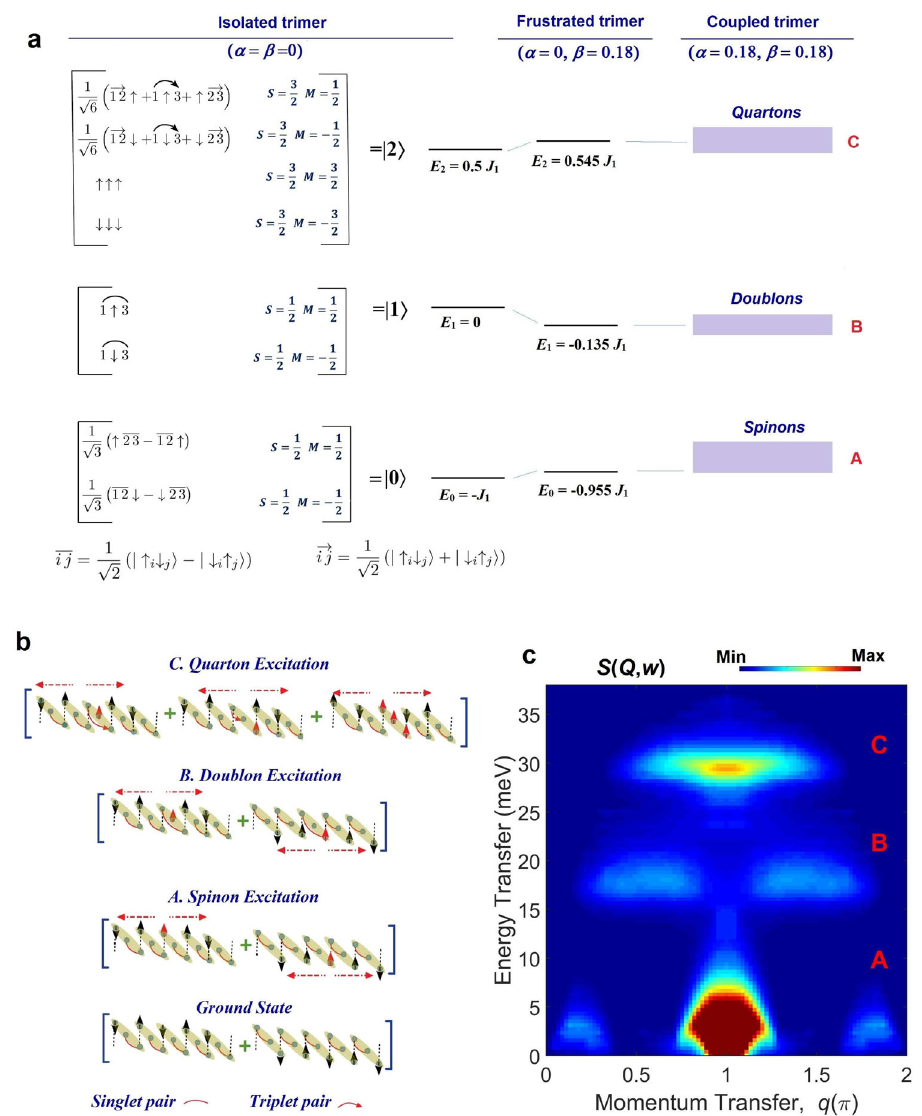
Fig. 2 | The energy level spectrum, wave functions, spin structures, and exci- tation spectrum of coupled spin-1/2 trimer-chain for the Hamiltonian of Na 2 Cu 3 Ge 4 O 12 .a Thelevelspectrumandcorrespondingwavefunctionsofisolated trimer in presence of (left) only NN J 1 and (middle) both NN and NNN interactions [ J 1 ,( J 3 = β J 1 with β =0.18)].The fi rstcolumnshowsthewavefunctionswhereisolated up and down spins are represented by up and down arrows, respectively and the singlet and triplet pairing between sites is denoted by lines and arrows, respec- tively. The corresponding total spin quantum number and magnetic quantum number are given by S and M , respectively. The last column shows the level spec- trum for coupled trimers with J 2 (= α J 1 with α = 0.18). The exchange interaction J 2 introduces dispersion for each of the energy levels where the lowest level (A),